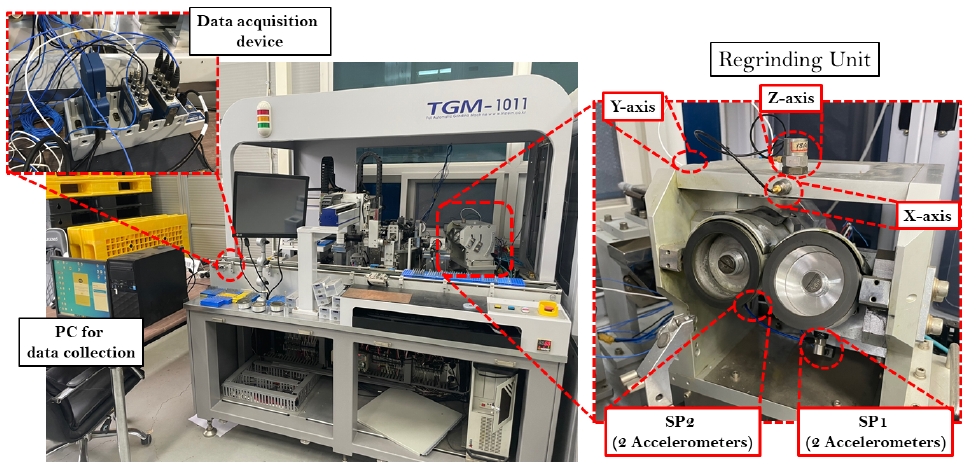
Figure 3. A picture of the micro drill bit ARIS (model TGM-1011) with the sensor locations and data acquisition system.